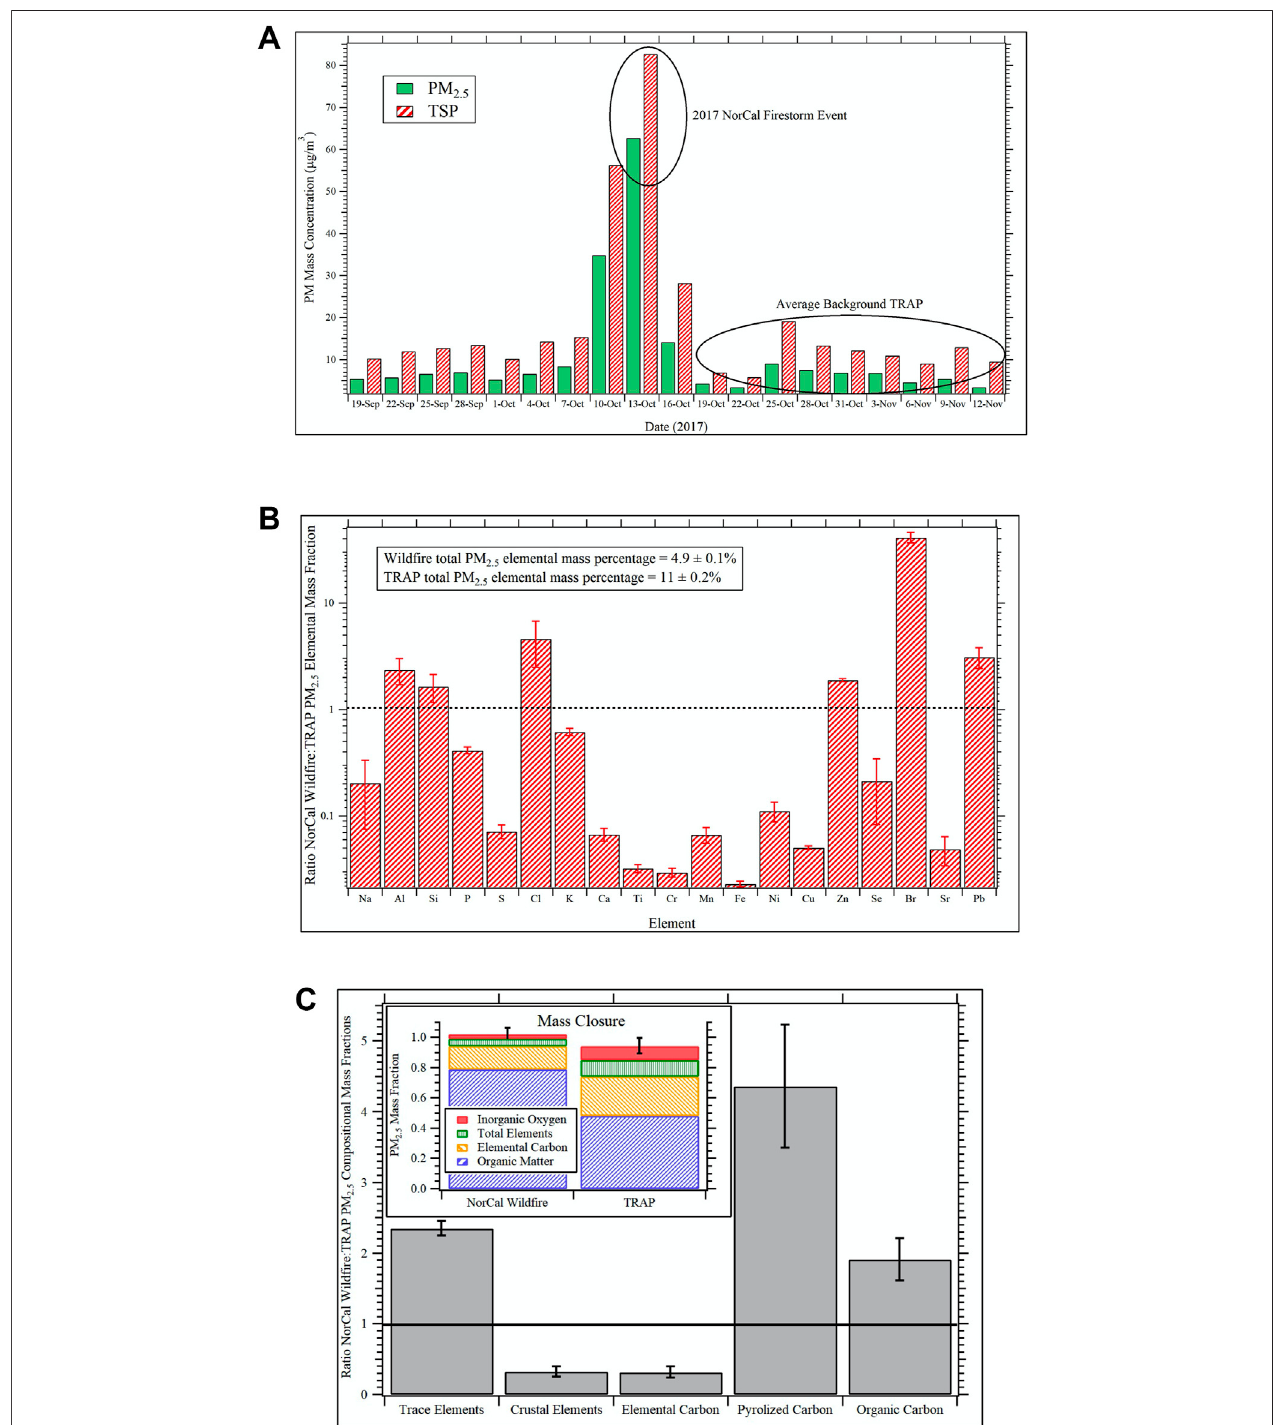
FIGURE 5 | Compositional intercomparison of the NorCal wild fi re and TRAP PM samples (A) Daily average PM 2.5 and TSP concentrations determined via gravimetric analyses of fi lter samples collected at the Caldecott Tunnel Exposure Facility before, during, and after the impact of the 2017 Northern California (NorCal) Firestorm from October 10th through the 16th. For the in vitro studies, the TSP fi lter sample from October 13th was used for the wild fi re exposure group while TSP collectedcontinuouslyfrom October19th through November 12thwas used forthe TRAPexposure group. (B) Fractional shiftindose normalized PM 2.5 elemental composition during the 2017 NorCal Firestorm event relative to the average background TRAP at the Caldecott Tunnel Exposure Facility. Values greater than unity — depictedbyblackdottedline — indicatetheelementisenhancedinthewild fi resamplerelativetoTRAPandviceversaforvalueslessthanone.Errorbarsare99%